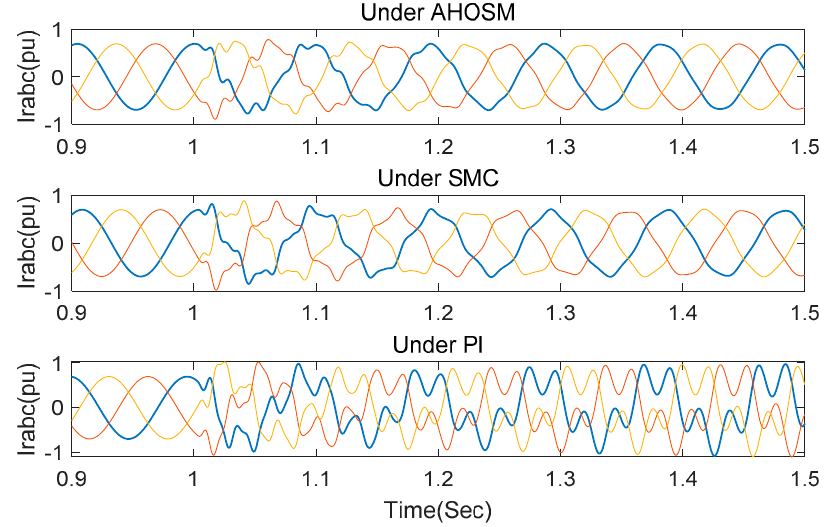
Figure 17. Responses of rotor under three control methods with series ‐ compensated level 70% and wind speed 11 m/s.